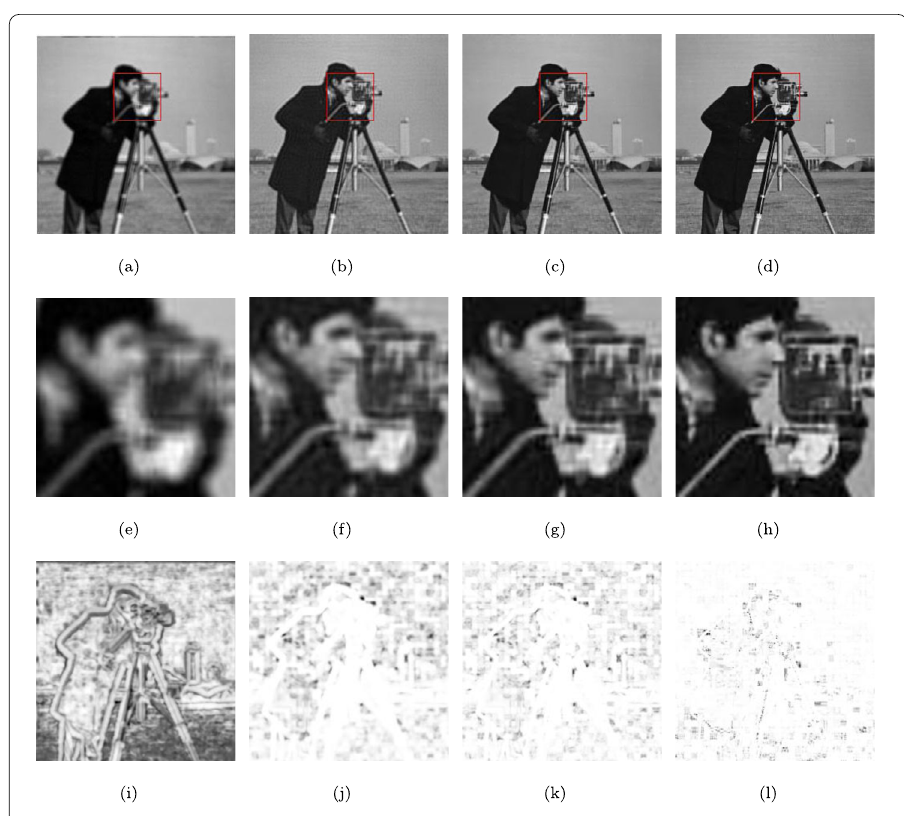
Figure 2 Results of different methods when restoring blurred and noisy image “Cameraman” degraded by Gaussian blur with Gaussian blur nucleus 9 ∗ 9 and a noise with BSNR = 35: ( a ) blurred and noisy image; ( b ) restored image by FastTV; ( c ) restored image by FNDTV; ( d ) restored image by our method; ( e ) zoomed part of ( a ); ( f ) zoomed part of ( b ); ( g ) zoomed part of ( c ); ( h ) zoomed part of ( d ); ( i ) SSIM index map of the corrupted image; ( j ) SSIM index map of the recovered image by FastTV; ( k ) SSIM index map of the recovered image by FNDTV; ( l ) SSIM index map of the recovered image by our